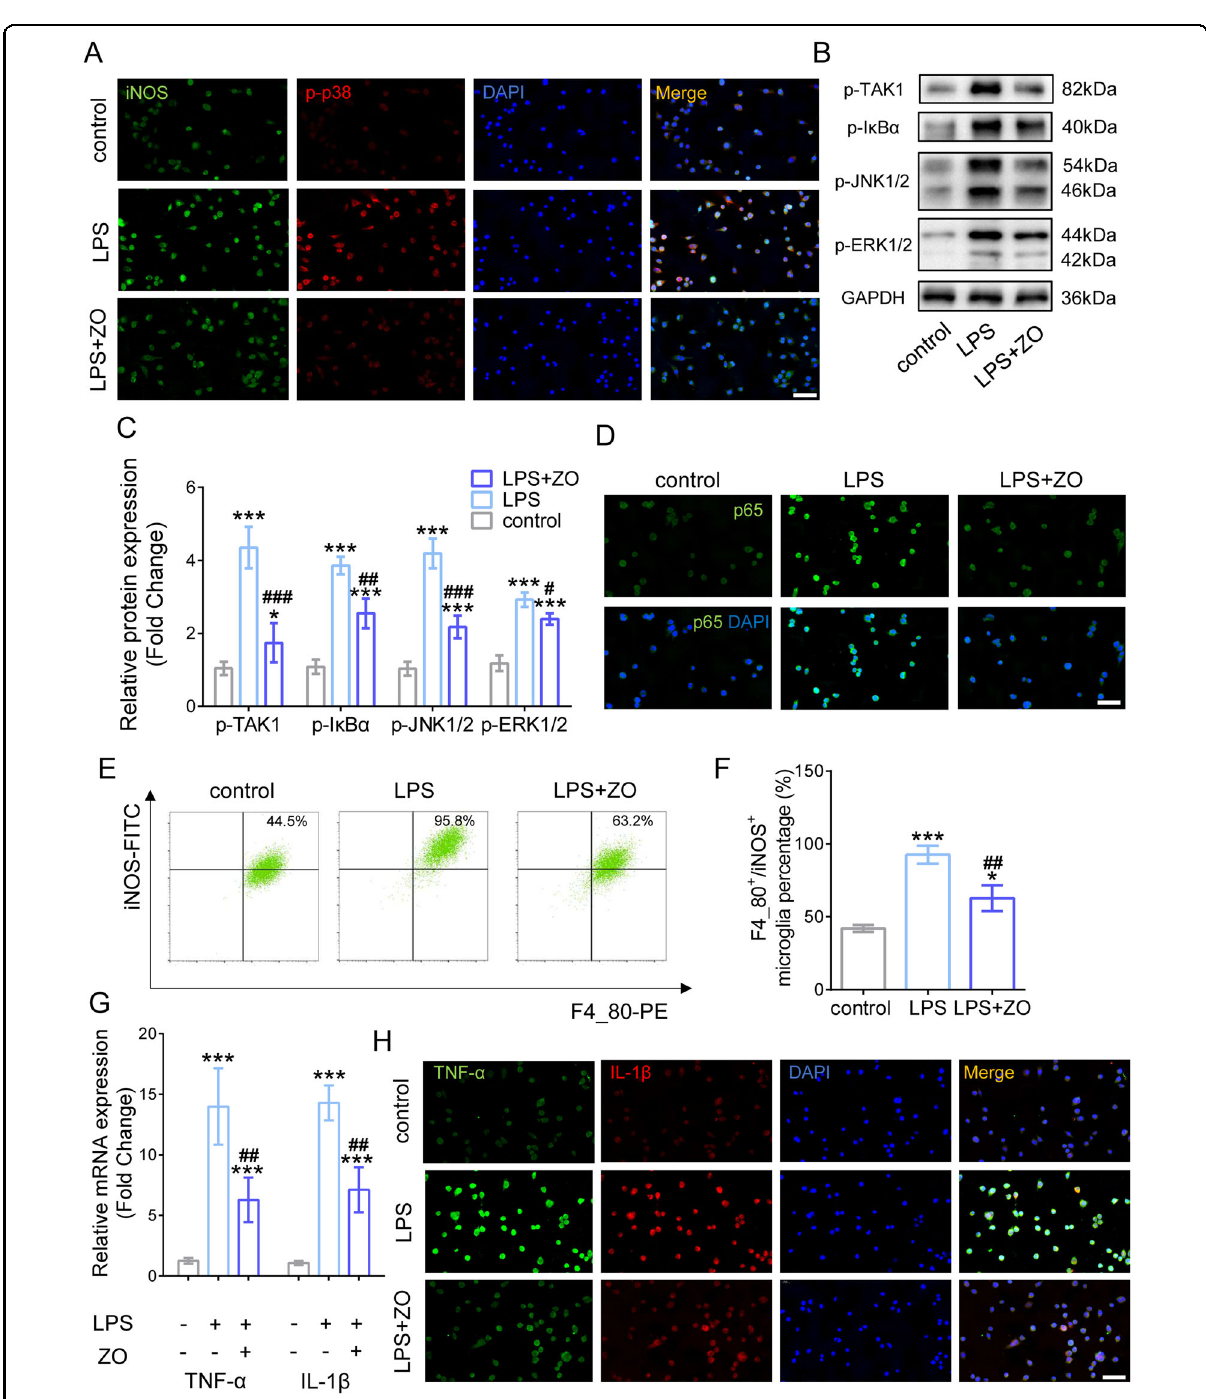
Fig. 2 Blocking TAK1 attenuates microglial in fl ammation by reducing MAPKs pathway. A Representative IF images of inducible nitric oxide synthase (iNOS) and p-p38; Bar scale = 50 μ m. B Western blotting of phosphorylation of TAK1, I κ B α (p-I κ B α ), JNK1/2 (p-JNK1/2), and ERK1/2 (p- ERK1/2) after TAK1 inhibition. C Quanti fi cation of p-TAK1, p-I κ B α , p-JNK1/2, and p- ERK1/2. ∗ P < 0.05, ∗∗∗ P < 0.001 versus control, # P < 0.05, ## P < 0.01, ### P < 0.001 versus L P S group. D Representative IF images of p65 in LPS-treated microglia after TAK1 inhibition; Bar scale = 50 μ m. E FCA results of F4_80-PE positive and iNOS-FITC positive cells. F Quanti fi cation of iNOS-FITC positive microglia ratio after ZO administration. G Quanti fi cation of tumor necrosis factor (TNF)- α and interleukin (IL) − 1 β . H Representative IF images of TNF- α and IL-1 β under TAK1 inhibition after LPS treatment; Bar scale = 50 μ